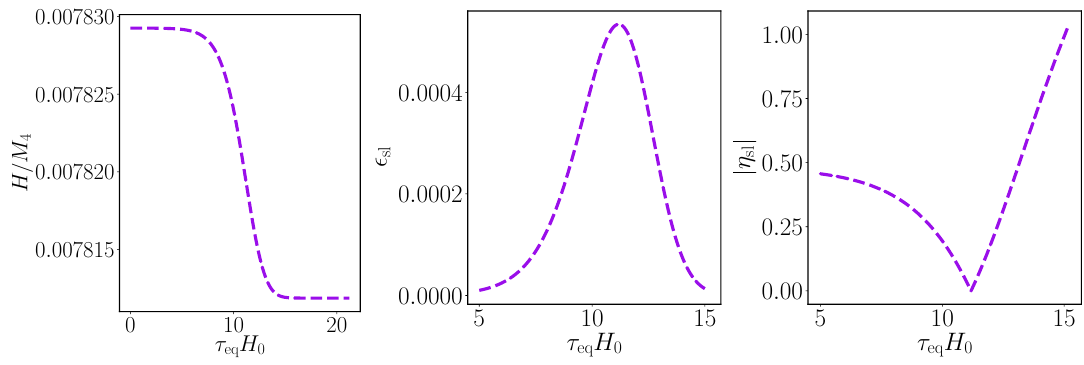
, flows to the solution 4 (middle) and sl